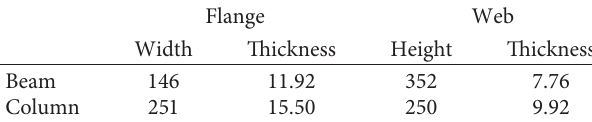
Figure 2: The cyclic reversed loading scheme. Table 1: Section sizes of the beam and column (unit: mm).